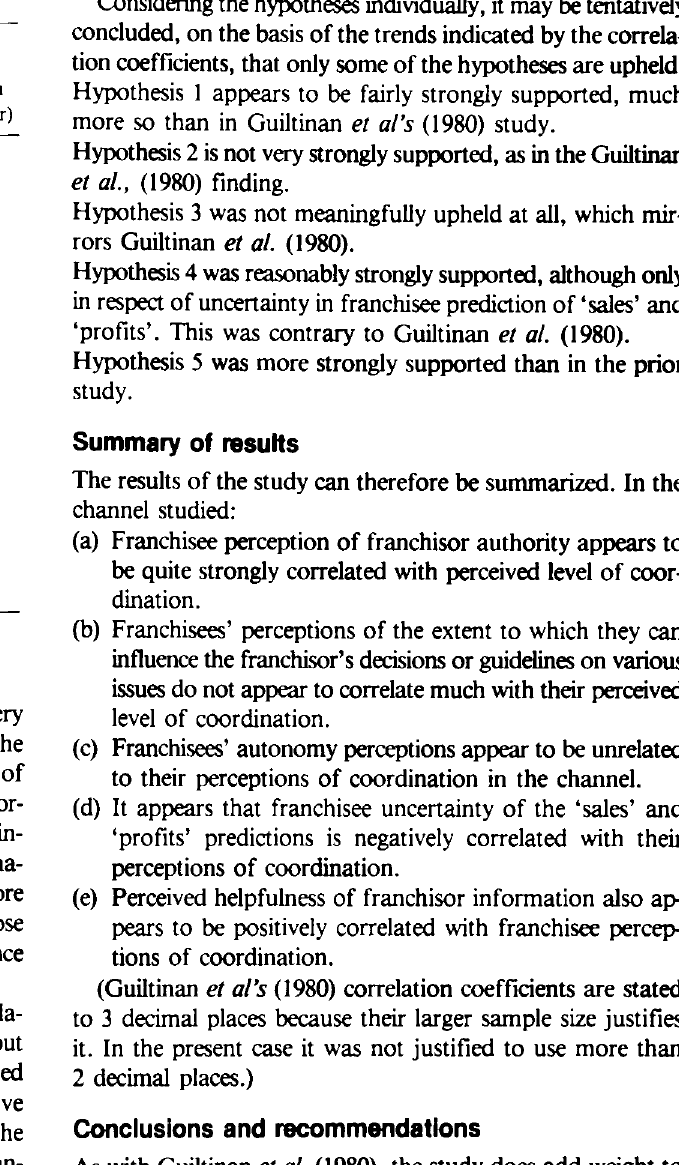
Table 3 Pair-wise correlations for coordination and other four